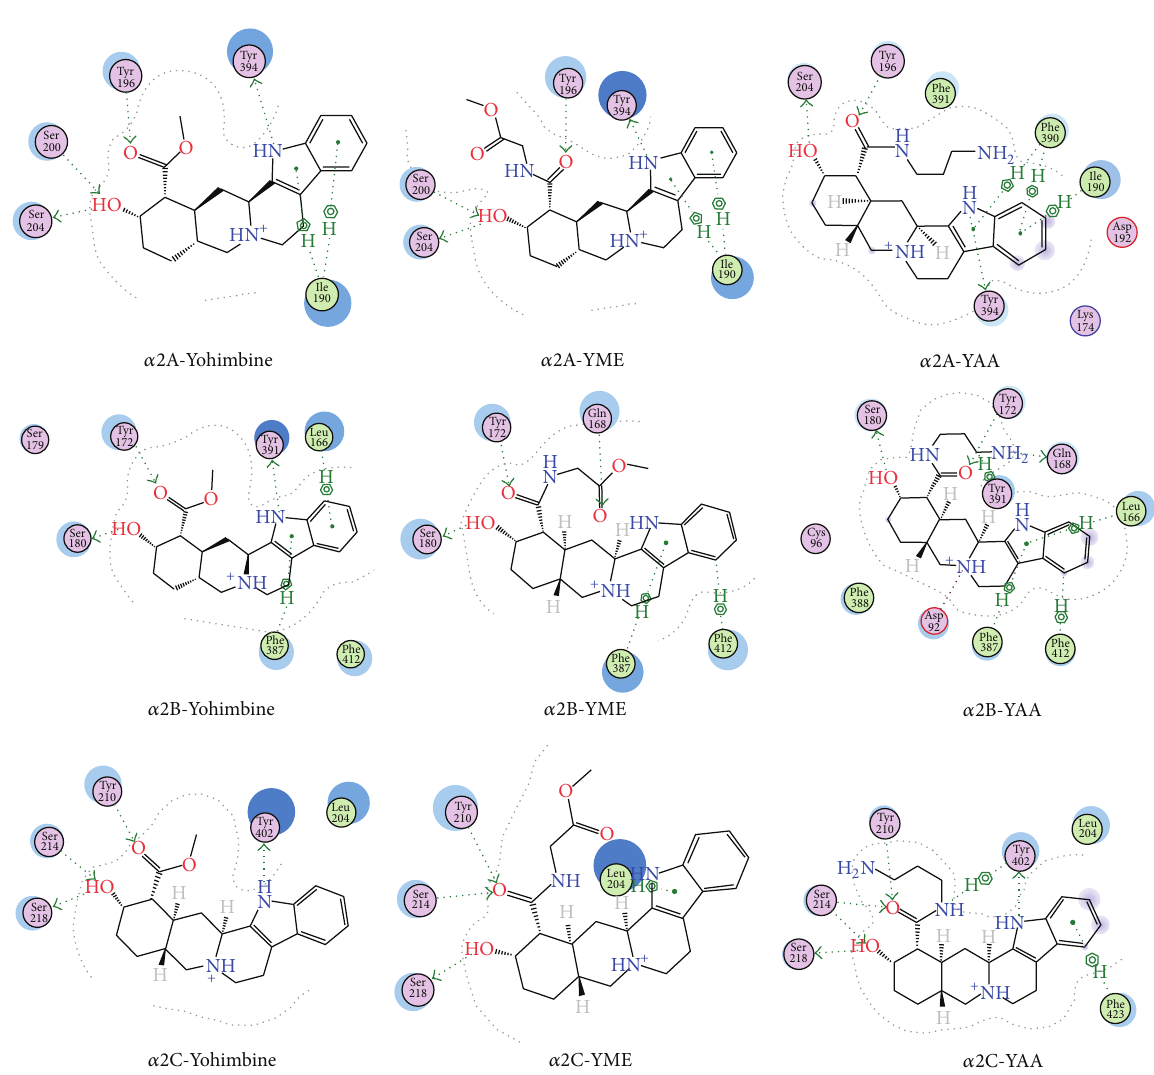
Figure 7: The binding modes of the 3 antagonists to 3 subtypes. Blue arrows represent hydrogen bonds formed with backbone atoms; green arrows represent hydrogen bonds formed with side-chain